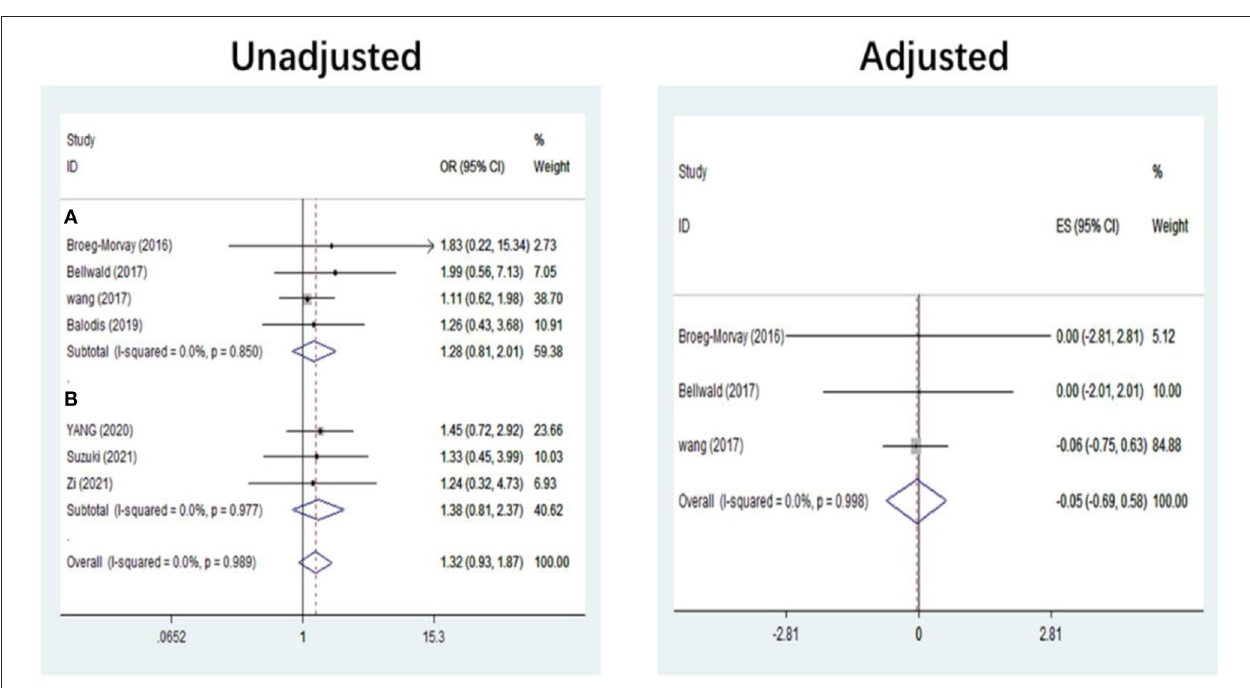
FIGURE 5 | Symptomatic intracranial hemorrhage. (A) Patients ineligible for IVT. (B) Patients eligible for IVT. IVT , intravenous thrombolysis; ES , effect size.